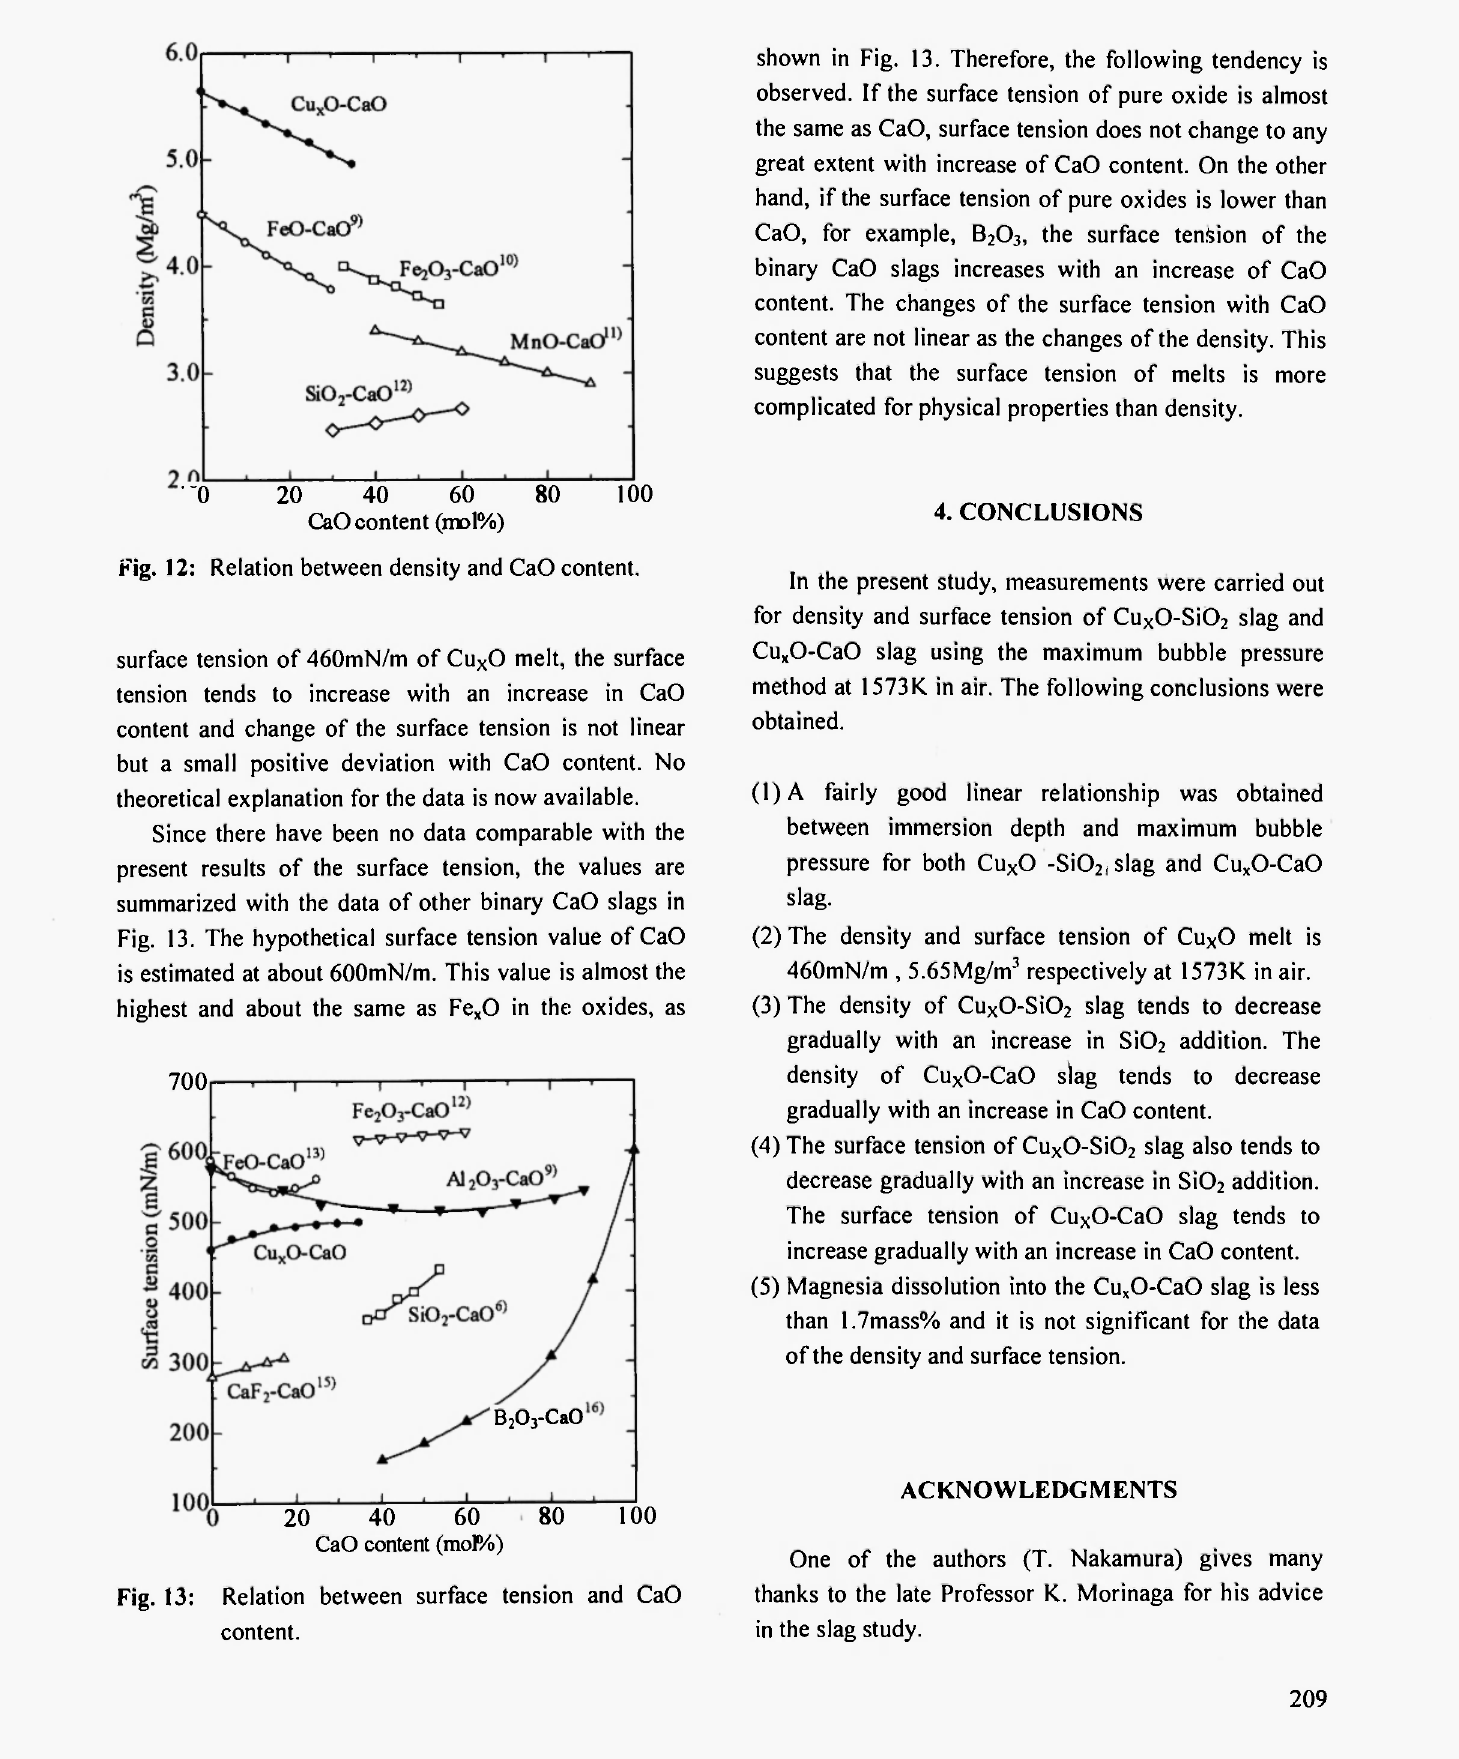
Fig. 13: Relation between surface tension and CaO